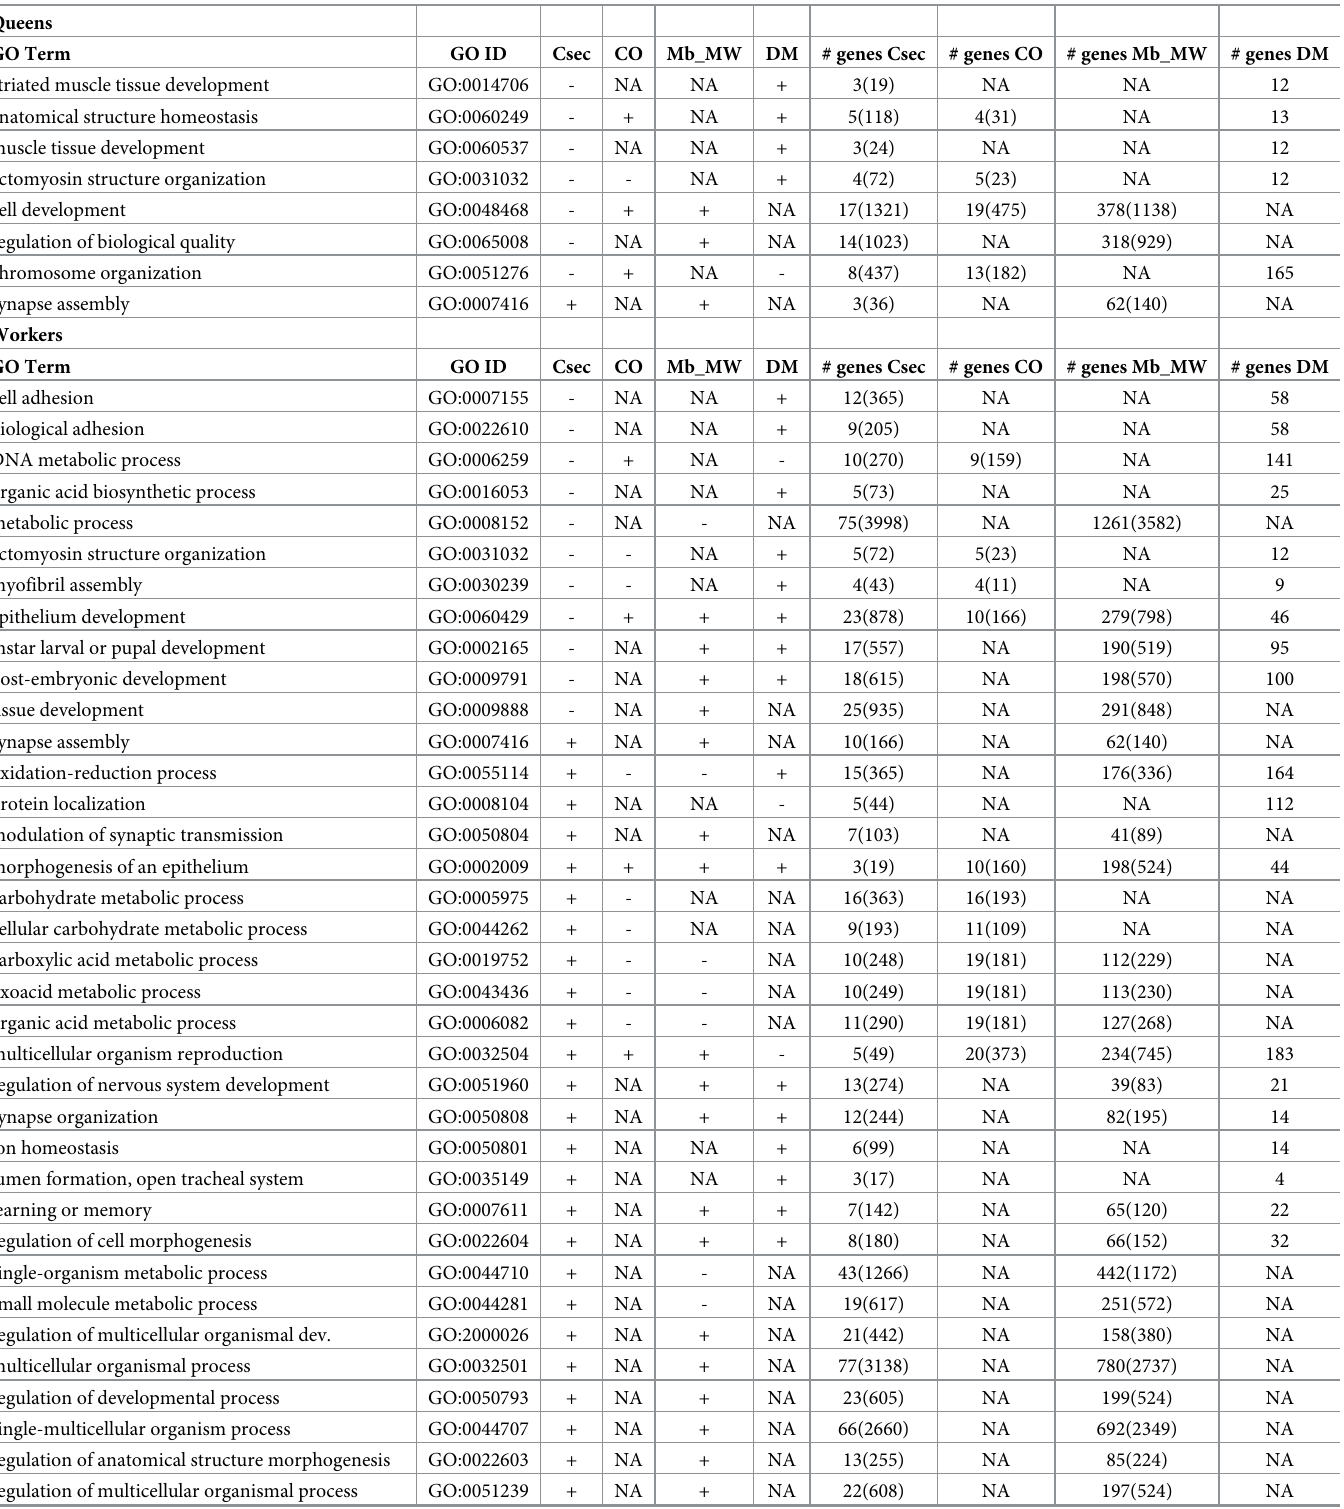
Table 1. Comparison of GO enriched terms between